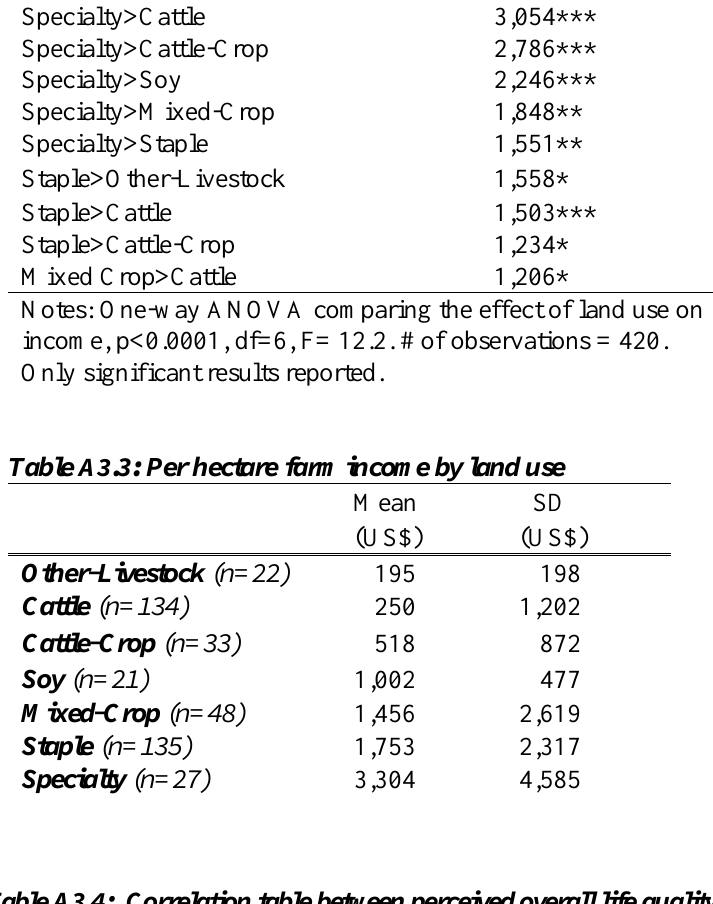
Table A3.4: Correlation table between perceived overall life quality and other measures of satisfaction Rural